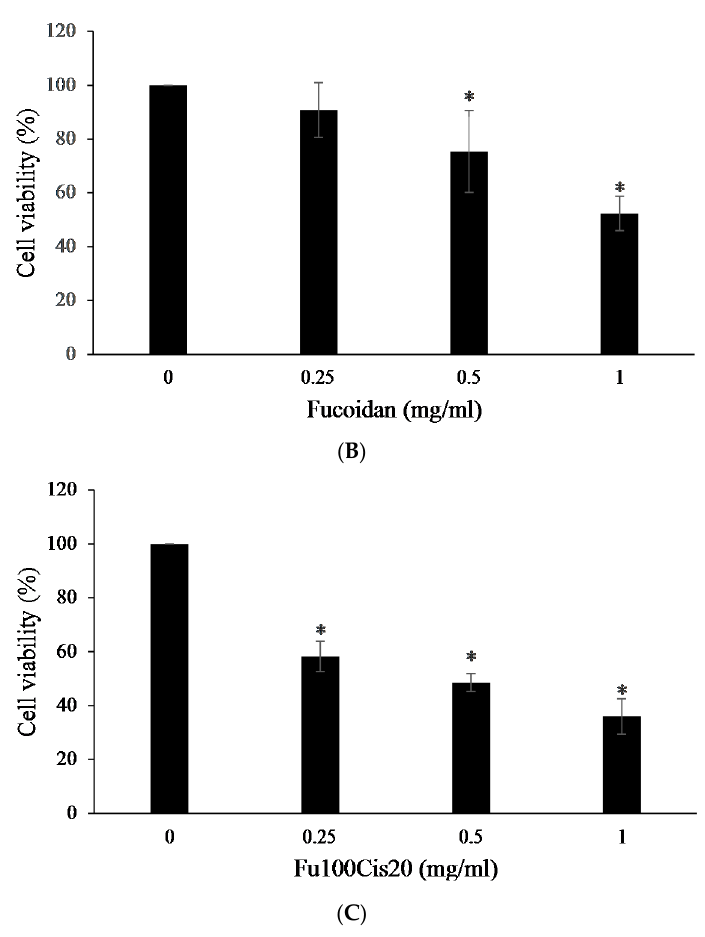
Figure 3. Cell viability results of ( A ) cisplatin; ( B ) fucoidan and ( C ) Fu100Cis20 in HCT-8 cells for 24 h. Values were expressed as mean ± SD, n = 5. * p < 0.05 when compared with 0 mg/mL group.